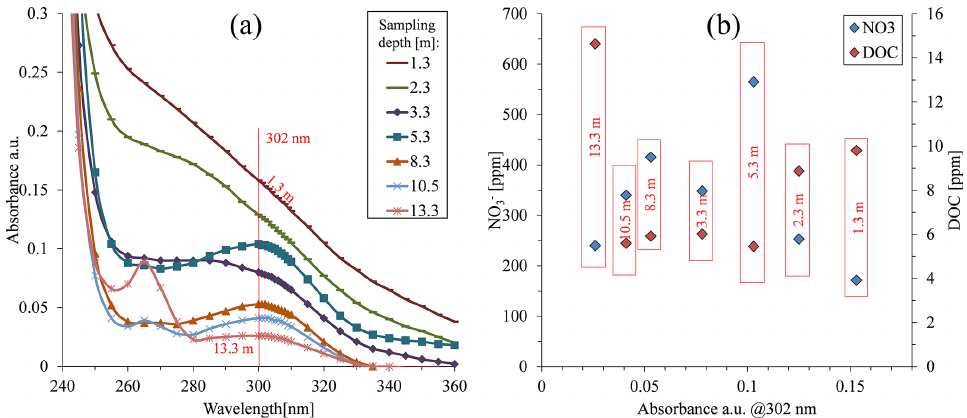
Figure 4. Absorbance in the 300nm region of samples taken under the organic greenhouse. Both nitrate and dissolved organic carbon (DOC) concentration values are presented.